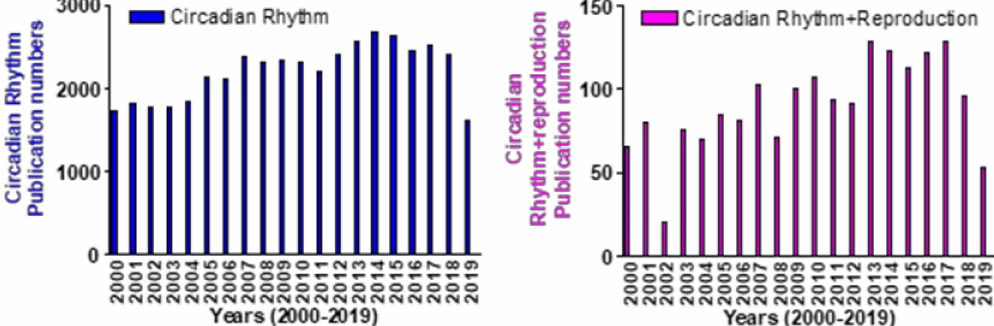
Figure 2. The number of references found for each year (From 2000 to 2019) of publication on the PubMed database using the keyword ‘Circadian Rhythm’ (left) or ‘Circadian Rhythm + Reproduction’ (right). In 2019, this number of Circadian Rhythm was 1621, the number of Circadian Rhythm reproduction was